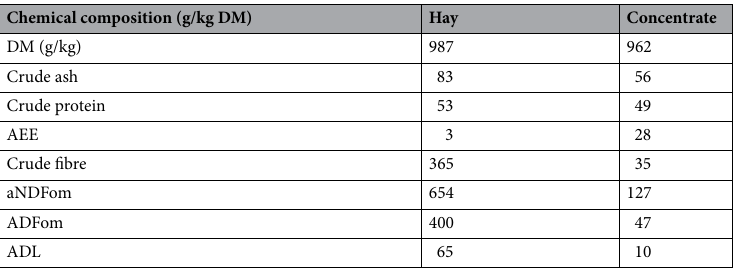
Table 2. Dry matter and crude nutrient concentrations of meadow hay and the concentrate fed to the sheep used for ruminal fluid collection. ADFom, acid detergent fibre expressed exclusive of residual ash; ADL, acid detergent lignin; AEE, acid ether extract; aNDFom, amylase-treated neutral detergent fibre expressed exclusive of residual ash; DM, dry